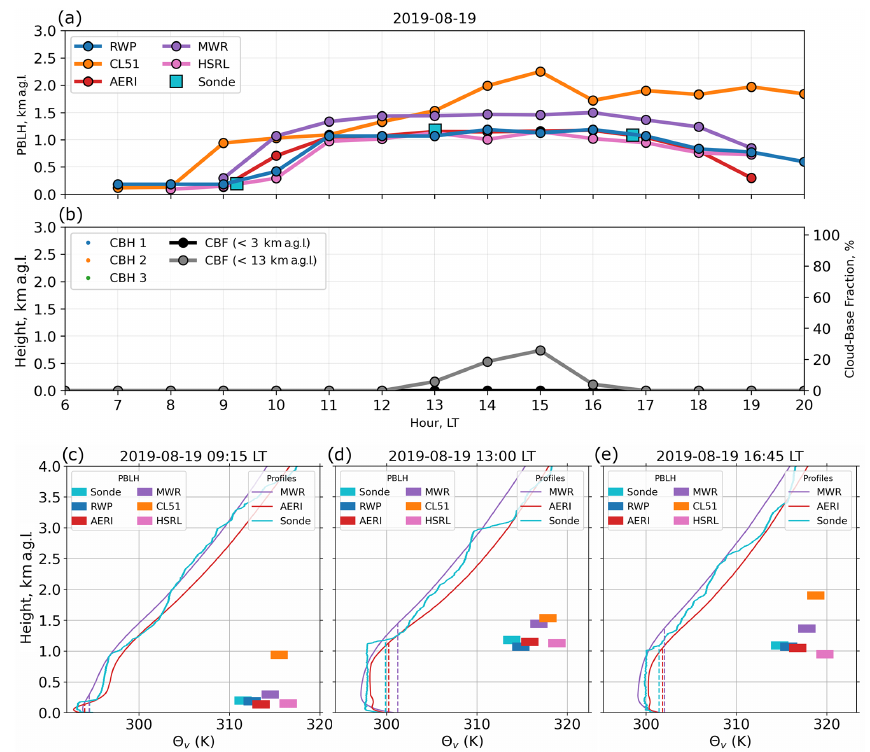
Figure 15. Case study 19 August 2019. (a) Time series of PBLH estimates from the different instruments between sunrise and sunset. (b) Cloud base height estimates (CBH 1, CBH 2, and CBH 3) and cloud base fraction (CBF) from the CL51 at Lakeland. (c–e) Profiles of virtual potential temperature at the radiosonde launch times (09:15, 13:00, and 16:45LT) from the radiosondes, AERI, and MWR, with vertical dashed colored lines representing application of the parcel method to the respective instrument profile. PBLH estimates at the time of the radiosondes from the different instruments are also denoted by the colored bars in (e, f)